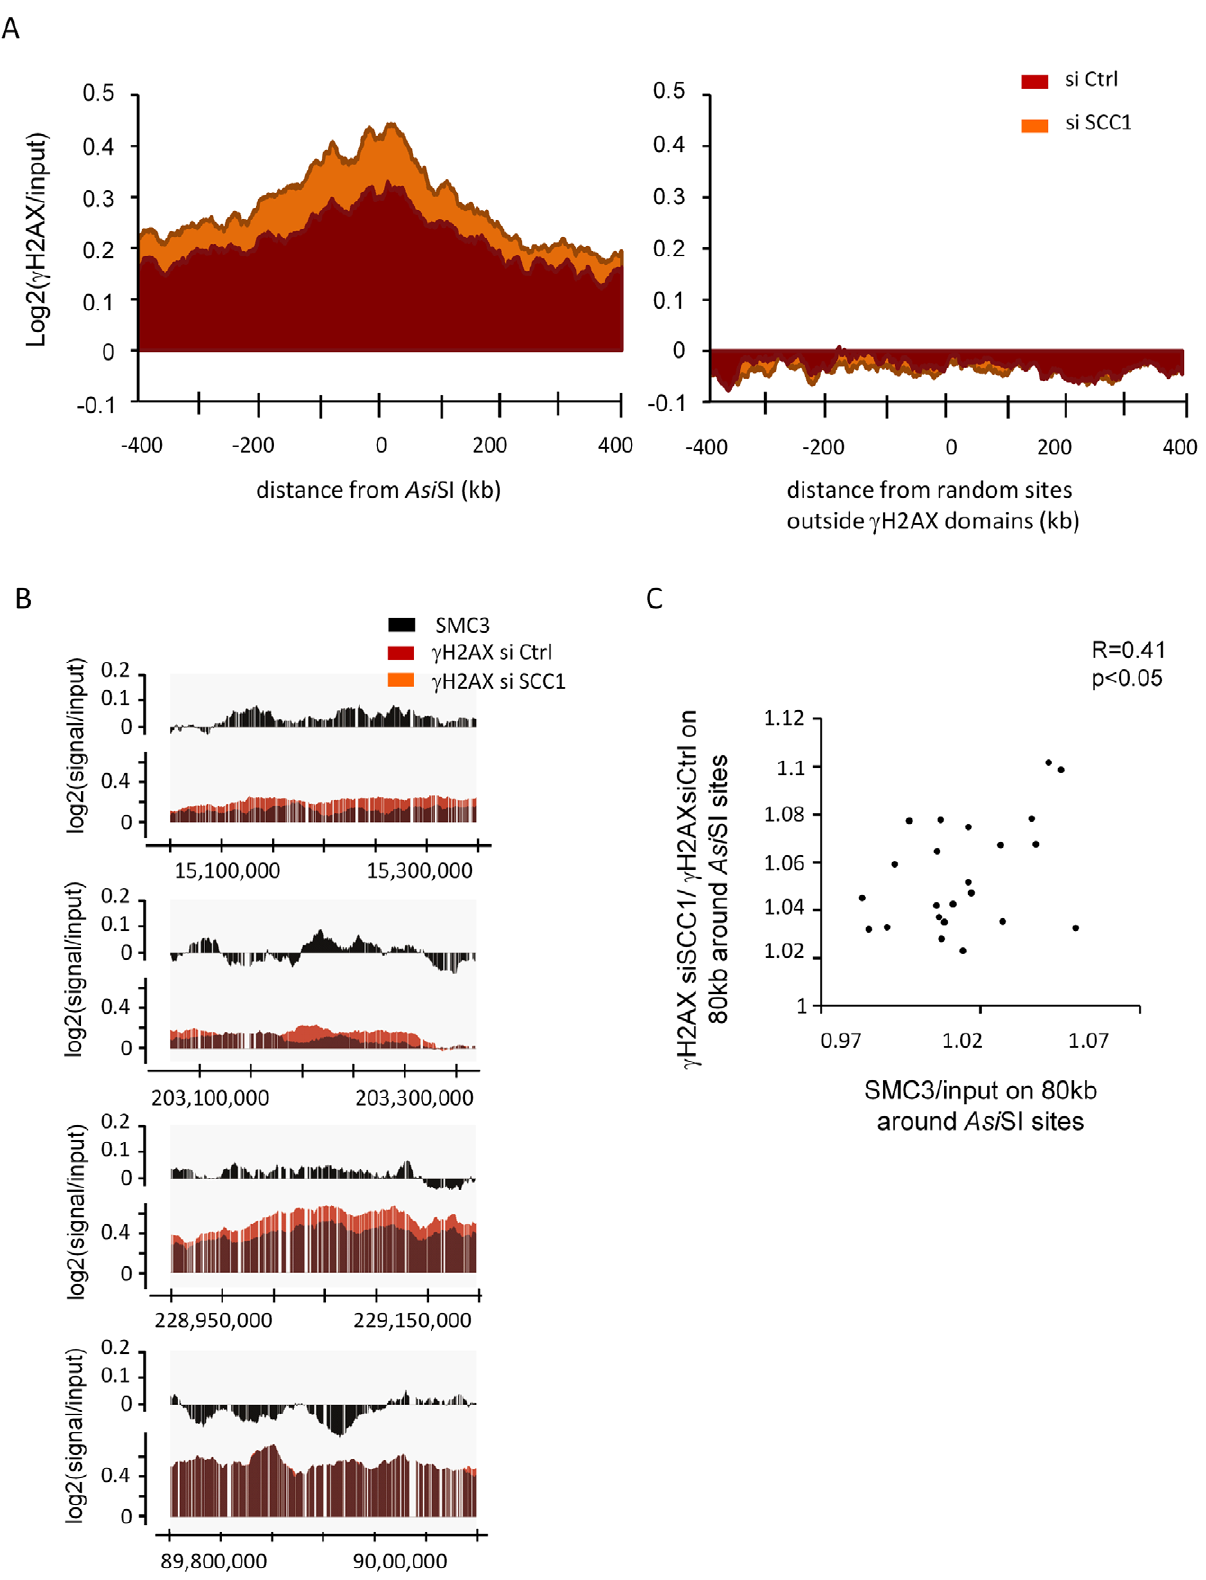
c H2AX (Top) and SMC3 (Bottom) over a 40 kb window centered on the hole borders and averaged using a 200 bp window size. Note the enrichment of SMC3 in the c H2AX holes.